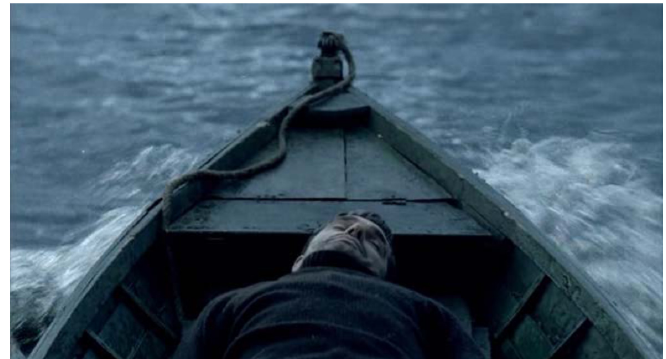
Figure 3. The Return (2003).